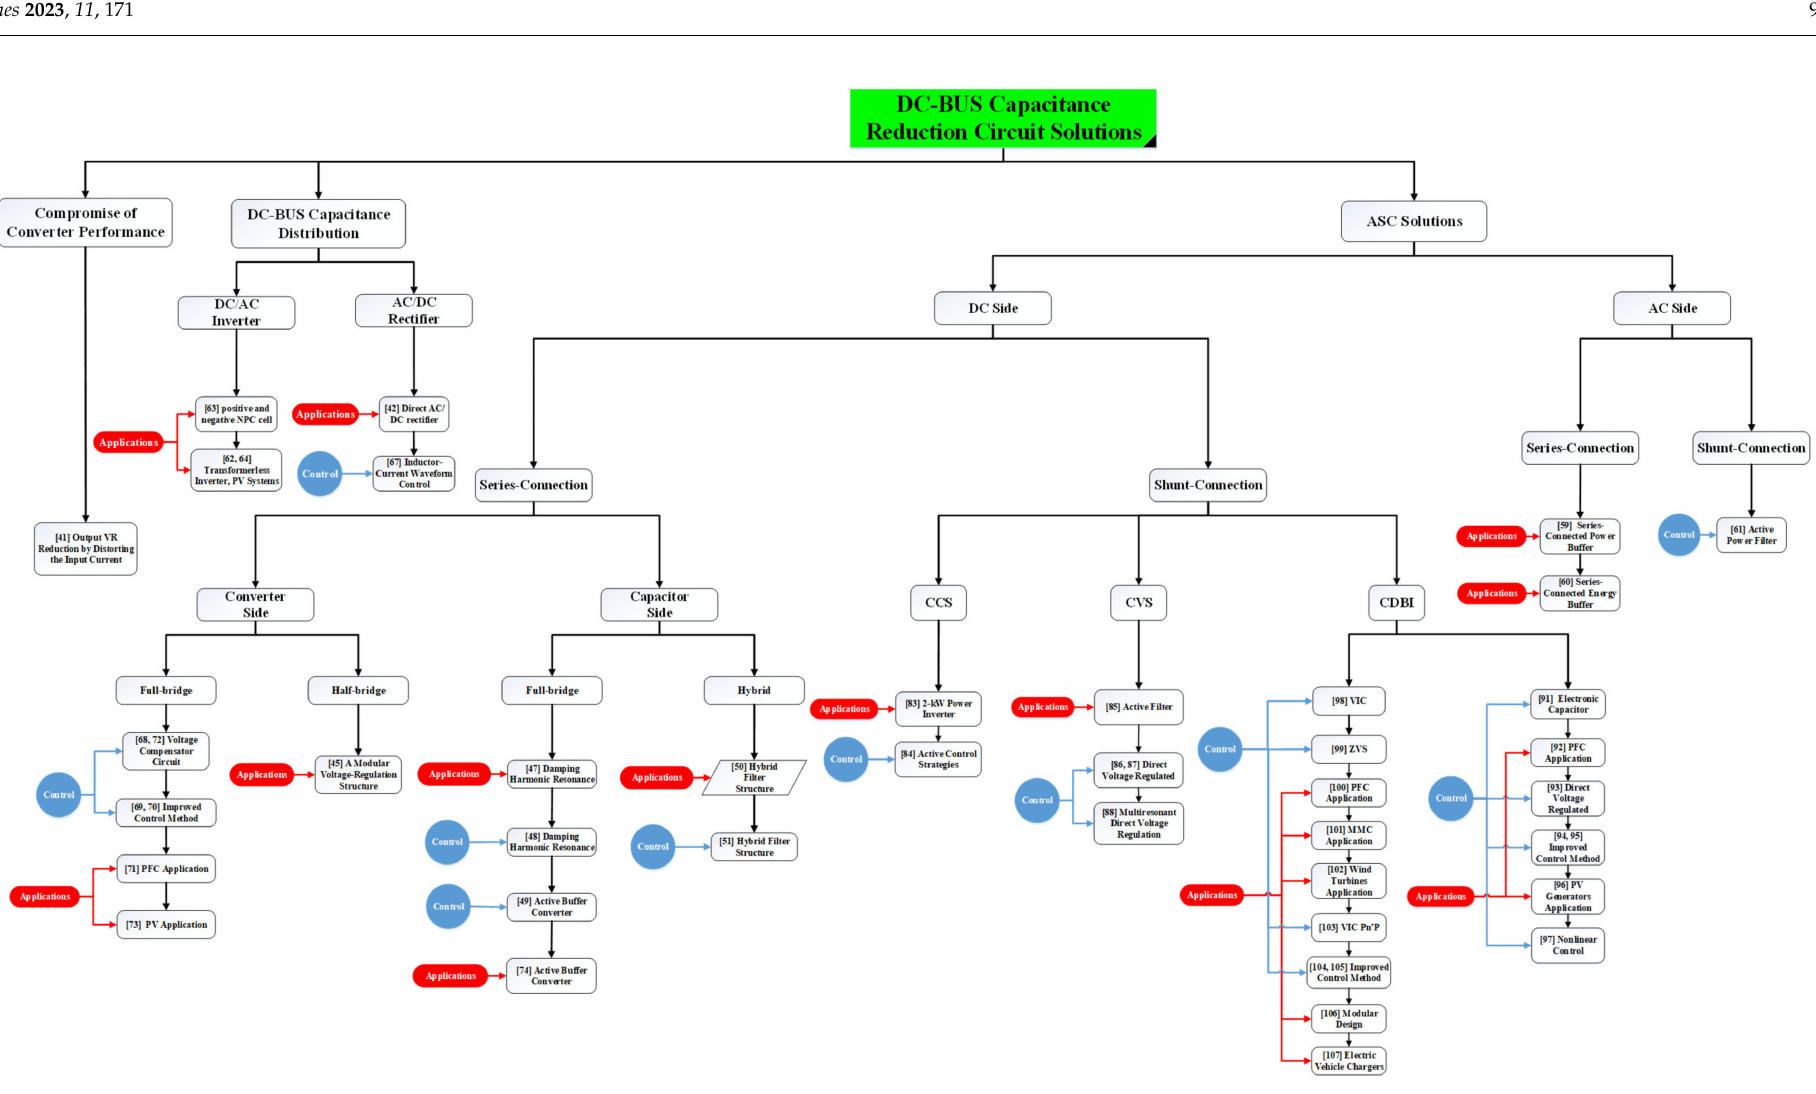
Figure 8. DC-BUS capacitance reduction circuit